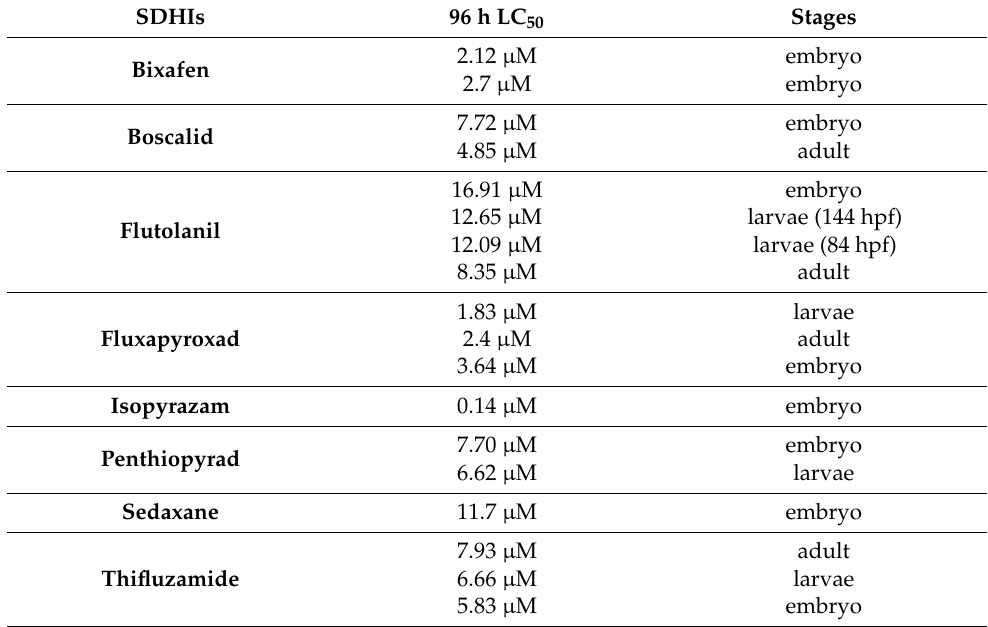
Table 1. LC 50 values of SDHIs determined in